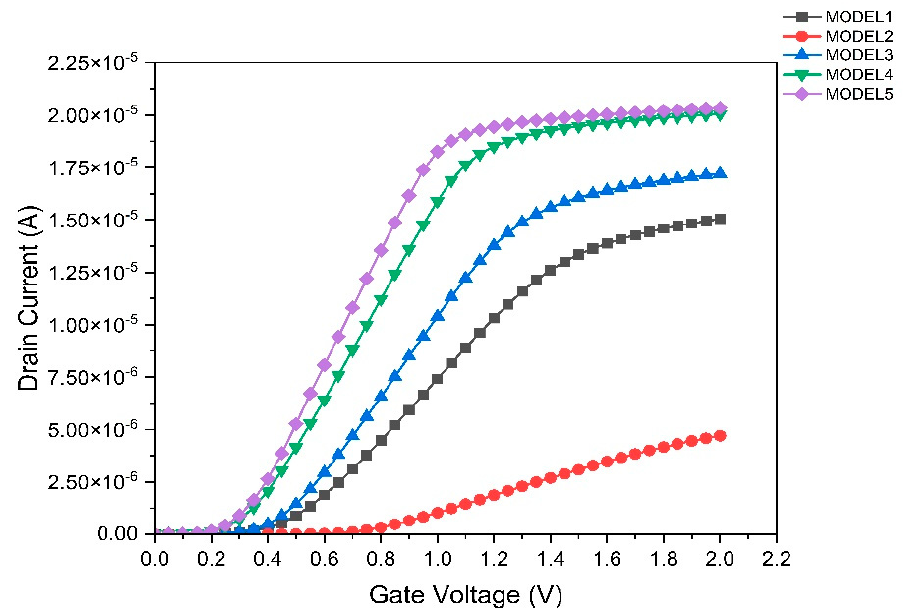
Figure 7. Transfer characteristic curves for five independently controlled SOI FinFET devices under different modes of operation.